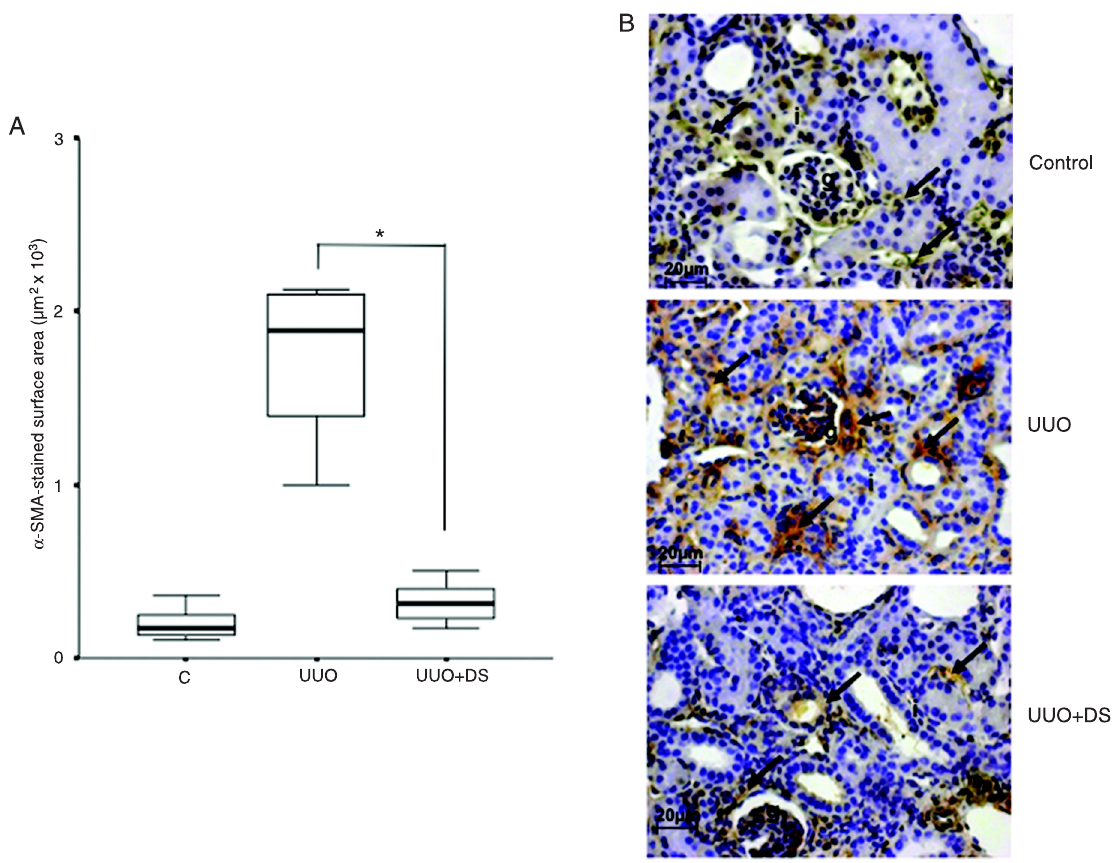
Figure 3. Myofibroblast accumulation in the kidney of mice submitted to different treatments. A , Myofibroblast accumulation was esti- mated by immunohistomorphometry of α-smooth muscle actin (α-SMA)-positive cells on kidney sections of mice from the control group (C), unilateral ureteral obstruction (UUO) group and unilateral ureteral obstruction plus dermatan sulfate group (UUO+DS). Data are reported as means ± SD for N = 6. The boxes represent the 25th and 75th percentiles, and the vertical bars represent the ranges, N = 30. B , The arrows in the UUO panel depict areas strongly stained for α-SMA compared with those less stained in control and UUO+DS panels. g = glomerulum; i = interstitium. Scale bar = 20 µm. Magnification 40X. *P < 0.05